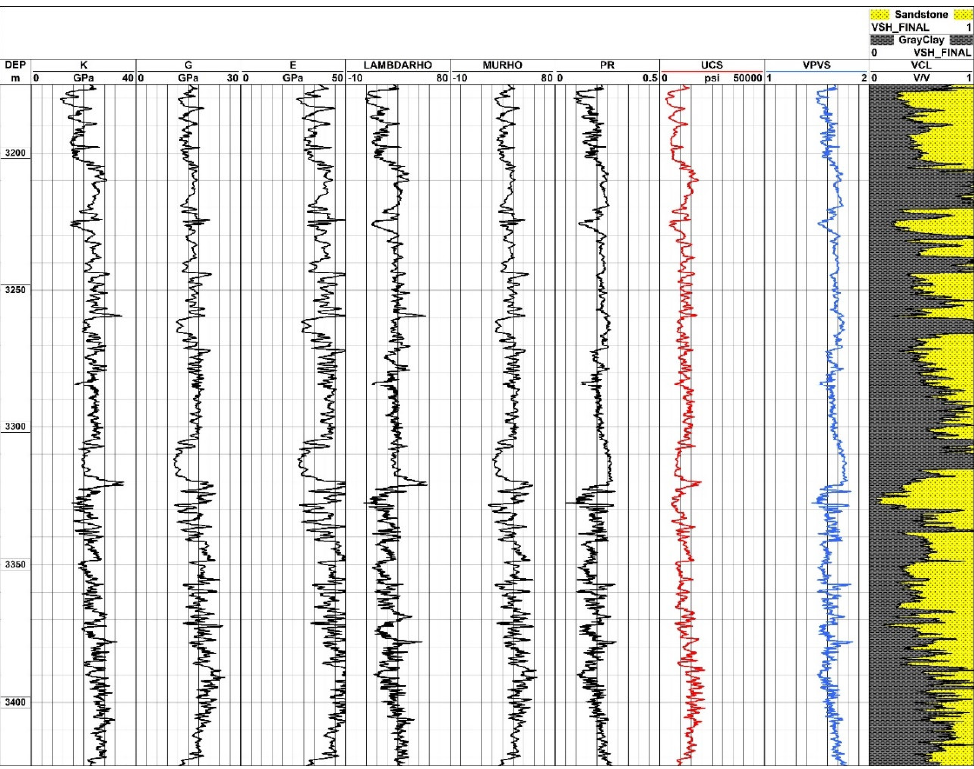
Figure 7. Mechanical rock parameters calculated for available depth interval in Miano-07 well. The lithology is also displayed in the colored column next to each plot.